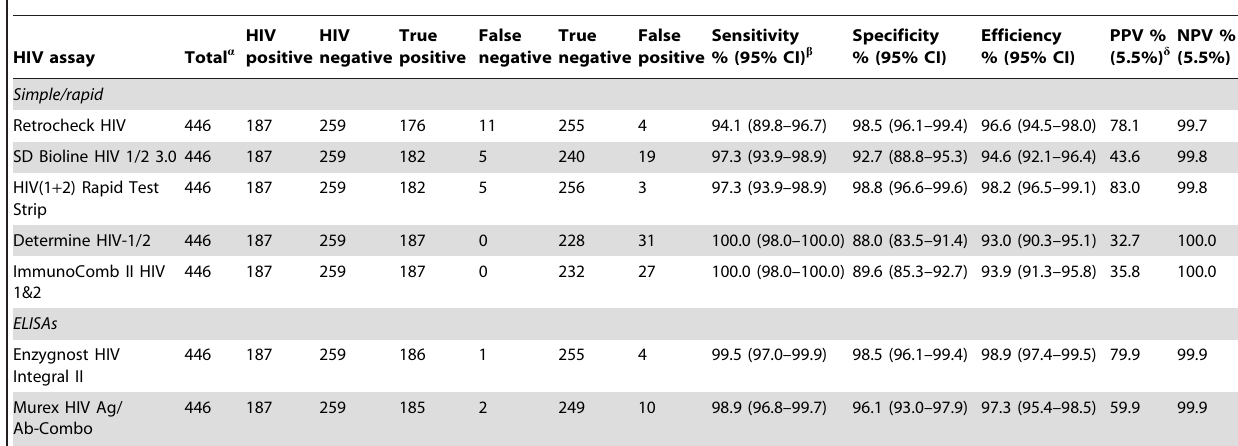
Table 2. Performance of HIV assays evaluated, indeterminate result samples excluded.